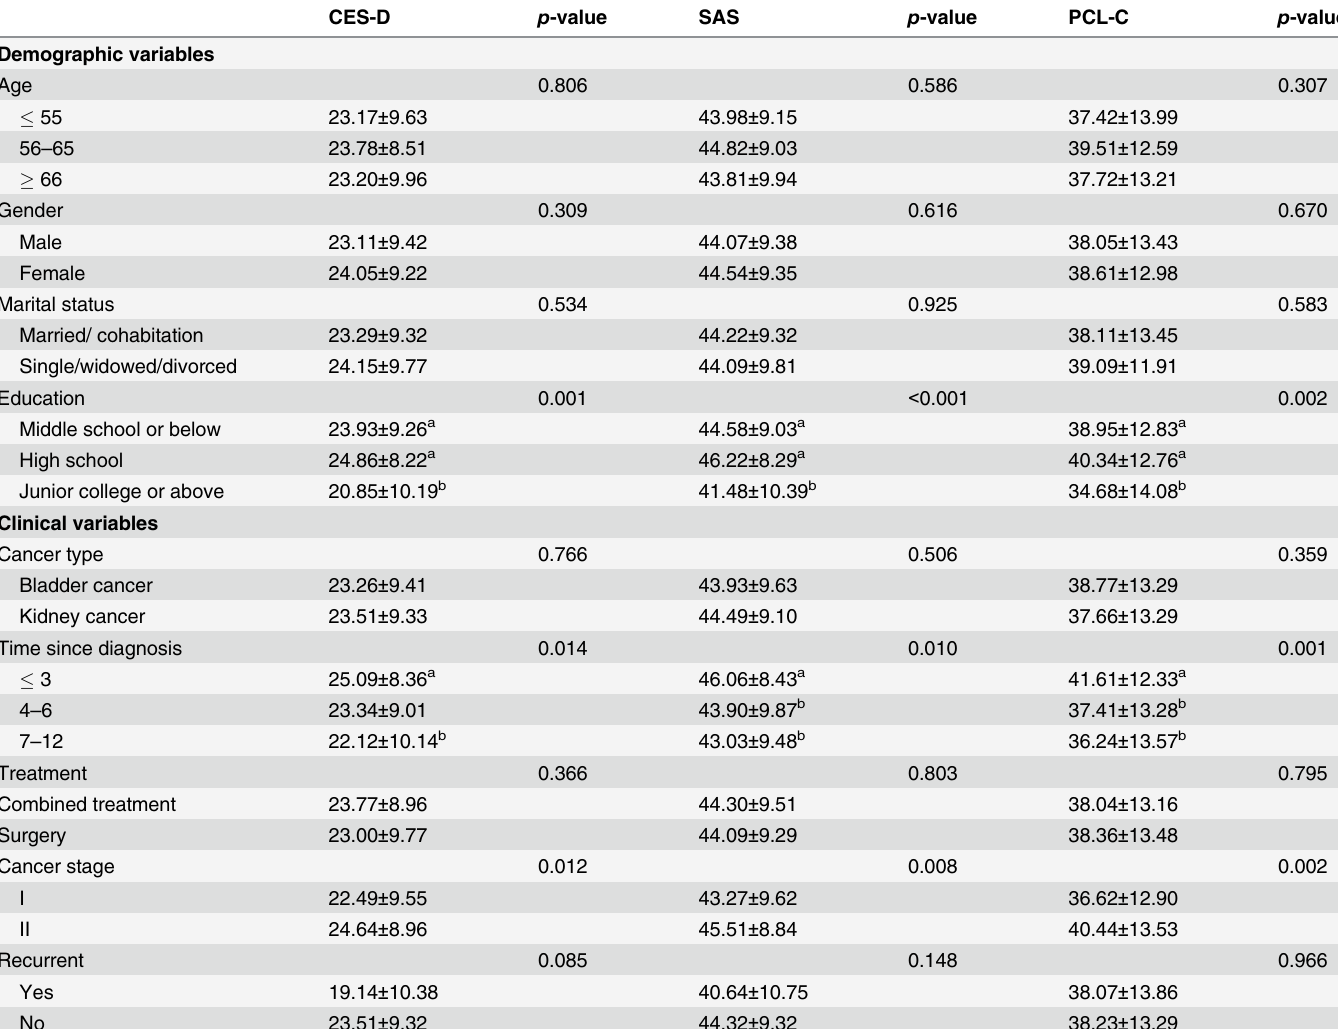
Table 2. CES-D, SAS, PCL-C scores in demographic and clinical